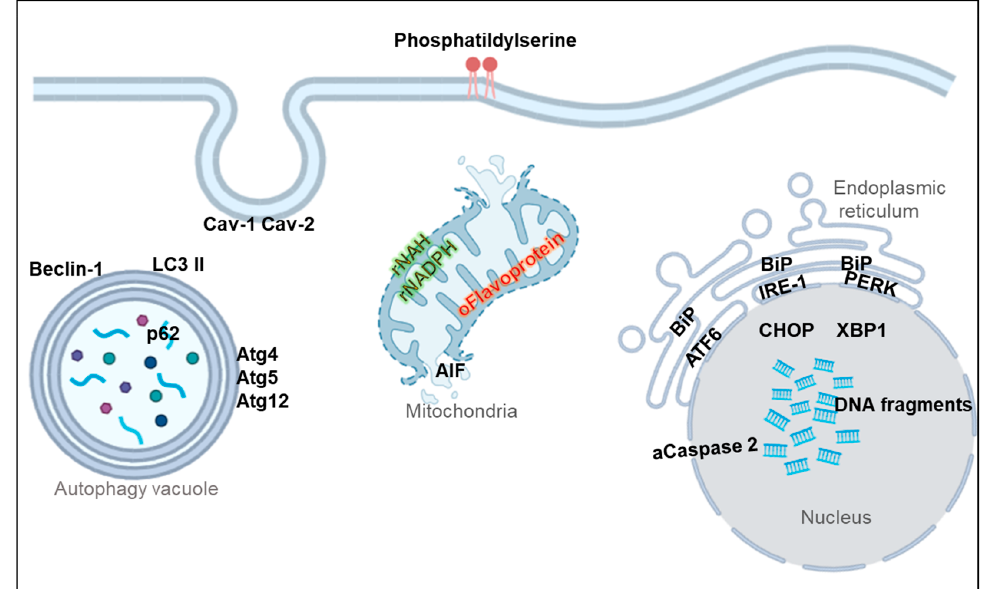
Figure 1. RGC degeneration biomarkers. Picture represents a cell and its organelles; markers are indicated in their preferred location. There are markers directly related to apoptosis such as phosphatidylserine (detected by Anexin V binding), activated caspase 2, or DNA fragmentation (detected by TUNEL, terminal labeling of deoxynucleotidyl transferase dUTP Nick). Mitochondrial dysfunction can be detected by measuring autofluorescence of reduced nicotinamide adenine dinucleotide (NADH) and nicotinamide adenine dinucleotide phosphate (NADPH) or oxidized Flavoproteins or by detecting AIF (apoptosis-inducing factor) release from the mitochondria to the nucleus. RGC degeneration may cause unfolded protein response and endoplasmic reticulum stress, which can be detected by measuring levels or changes in the localization of activating transcription factor 6 (ATF6), inositol requiring protein 1 (IRE1), the protein kinase RNA (PKR)-like ER kinase (PERK), the chaperone binding immunoglobulin protein (BiP) or the transcription factors X-box binding protein 1 (XBP1) and C/EBP homologous protein (CHOP). Changes in autophagy markers are also related to degeneration, markers such as becin-1 or autophagy proteins (Atg4, atg5, or Atg12), the autophagy substrate p62, and the microtubule-associated protein light chain 3 (LC3) II, are largely used as autophagy markers for RGCs. Totally unrelated to apoptosis are the levels of caveolins (Cav1 Cav2) in caveole membrane structures.